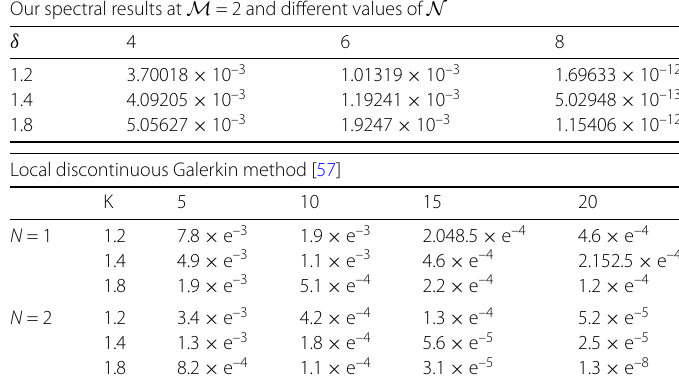
Table 2 L 2 -comparison for problem (2)